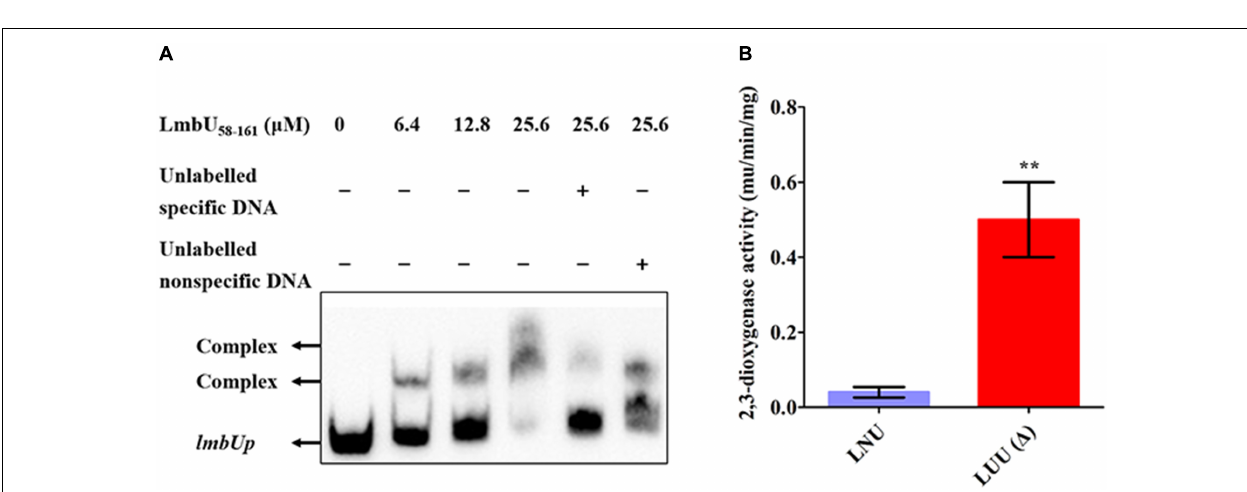
FIGURE 4 | Effect of R102 and R101 on the DNA-binding activity of LmbU. (A) EMSA analysis of LmbU variants His 6 -LmbU R 102 A and His 6 -LmbU R 102 K with lmbAp probe. (B) EMSA analysis of LmbU variants His 6 -LmbU R 101 A and His 6 -LmbU R 101 K with lmbAp probe.